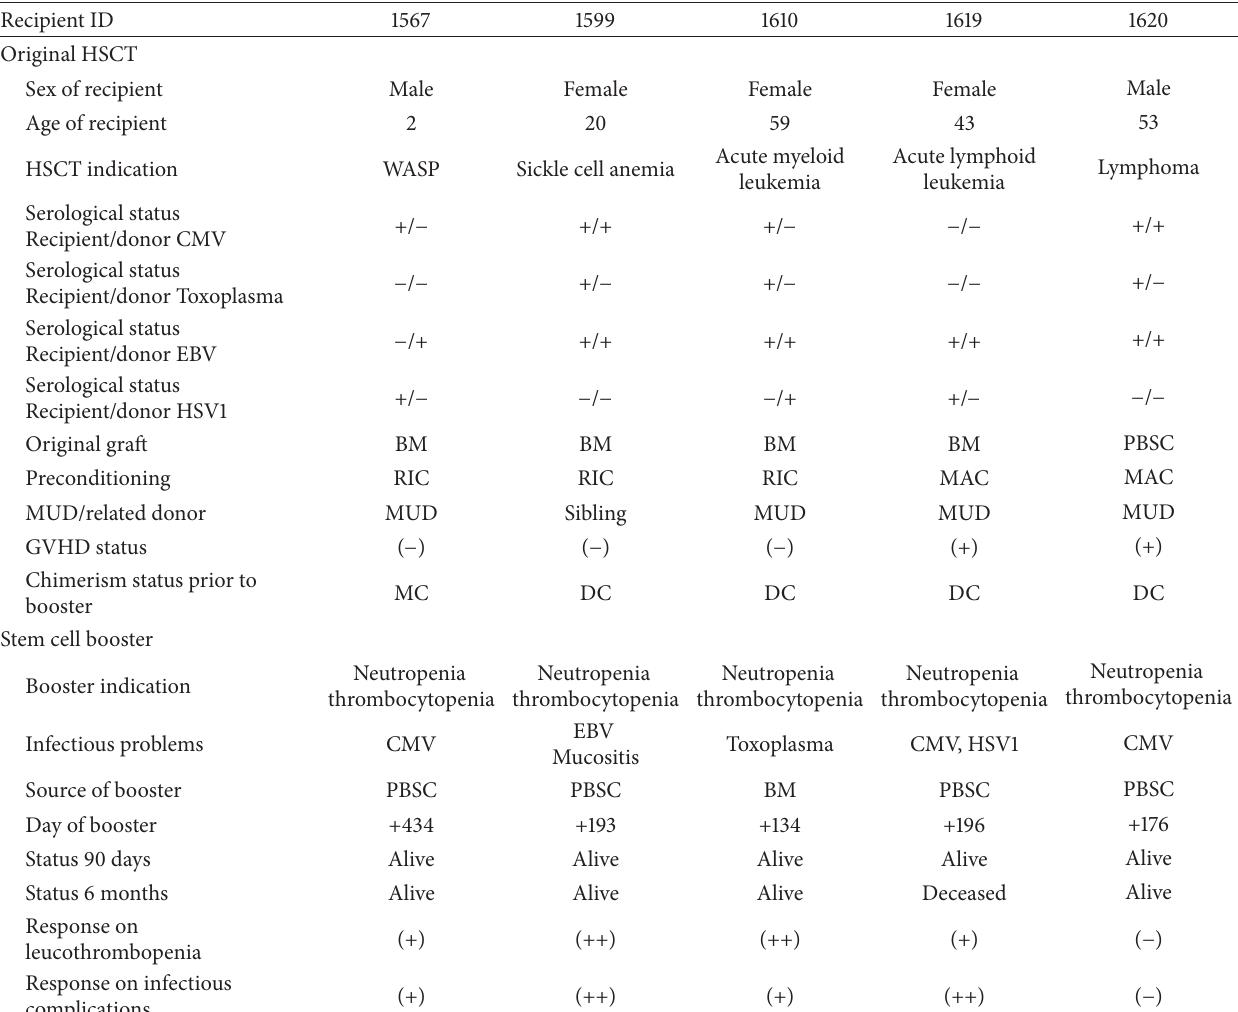
Table 1: Patient